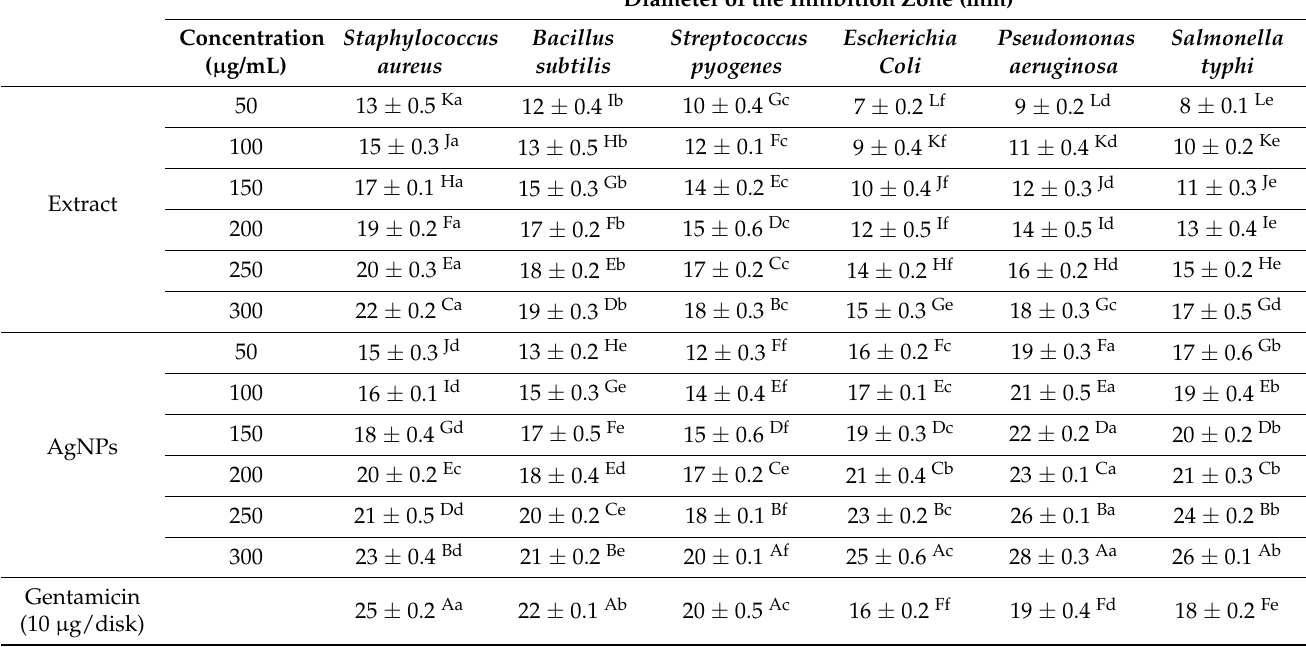
Various uppercase letters show significant differences among different concentrations of the extract and the AgNPs, and various lowercase letters show significant differences among different bacteria at the same concentration ( p <